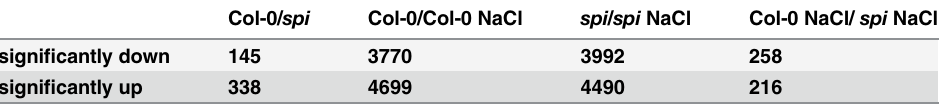
Table 2. Significantly changed gene expression between Col-0 and spi . Data present only those with a q-value < 0.01, Benjamini Hochberg (related to Fig